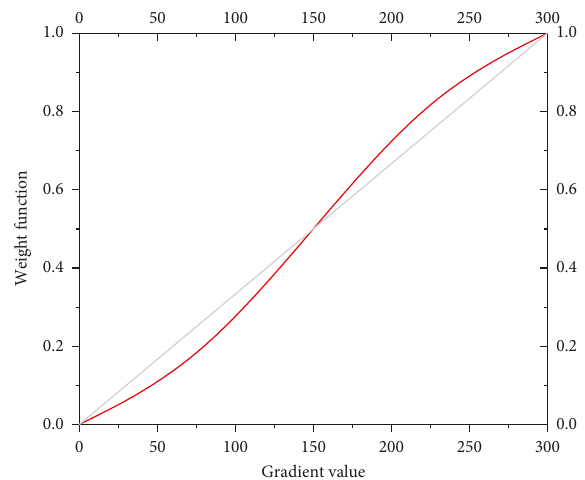
Figure 1: Schematic diagram of weight function M-S algorithm. The basic idea of the M-S algorithm is to assume that the grayscale distribution of the image to be segmented in the homogeneous area is a constant value.